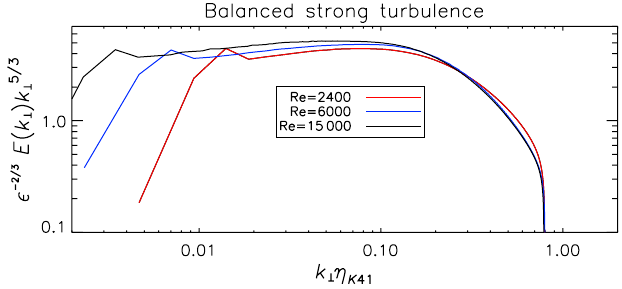
FIG. 9. The spectra presented in Fig. 8 rescaled with a new parameter (cid:10) K 41 ¼ (cid:1) 3 = 4 (cid:9) (cid:1) 1 = 4 . For this particular choice, (cid:10) K 41 is proportional to the step of numerical discretization, that is, (cid:10) ¼ const . According to our estimate of the onset of N ? K 41 the dissipation region in Fig. 8, the corresponding region in the present plot starts at k ? (cid:10) K 41 (cid:10) 0 : 04 , while the numerical dialiasing cutoff that is always imposed at k ? ¼ N ? = 3 is seen at k ? (cid:10) K 41 (cid:10) 0 : 8 . We observe that the convergence is present in the vicinity of the dealiasing cutoff, k ? (cid:10) K 41 * 0 : 3 , while it is absent in the inertial interval and in most of the dissipation